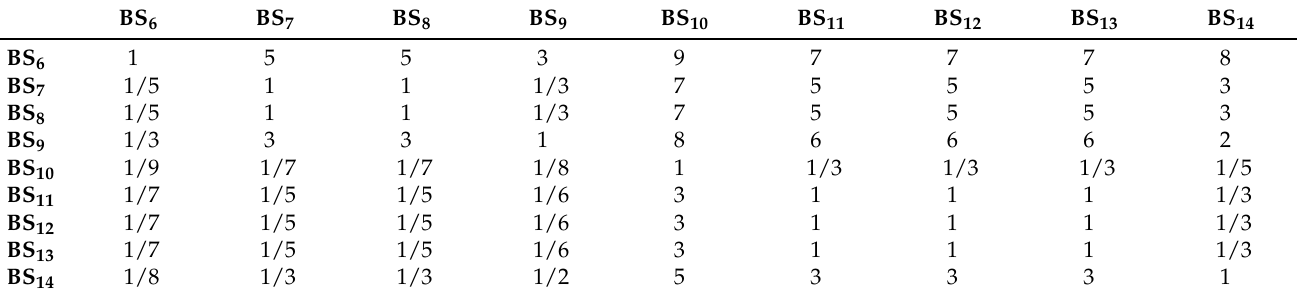
Table A14. The pairwise comparison matrix Admin _ C 2 .